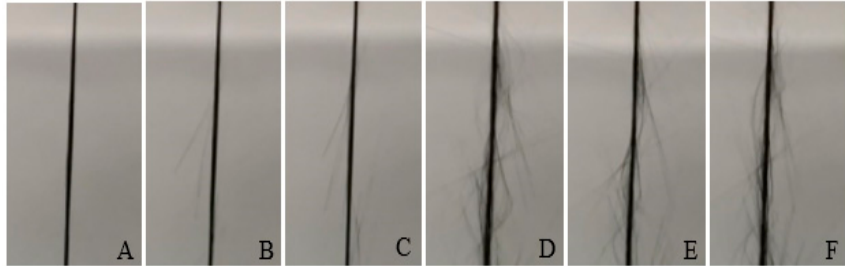
Figure 10. Pictures for the 1 K filament during the tensile test ( A ) before breakage, ( B ) partially broken,